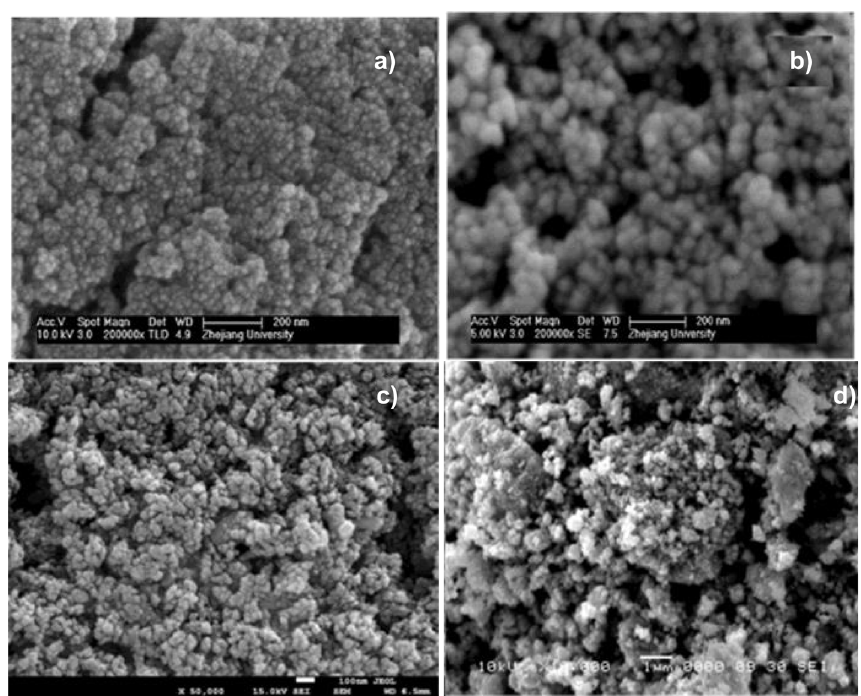
Fig. 4 SEM analyses of various size nano particles A spherical shape and average size about 12nm at 200oC [99], B spherical shape and average size about 53nm at 250oC [99], B spherical shape and size less than 100 nm [100], and D spherical shape and size varies from 24 to 65 nm